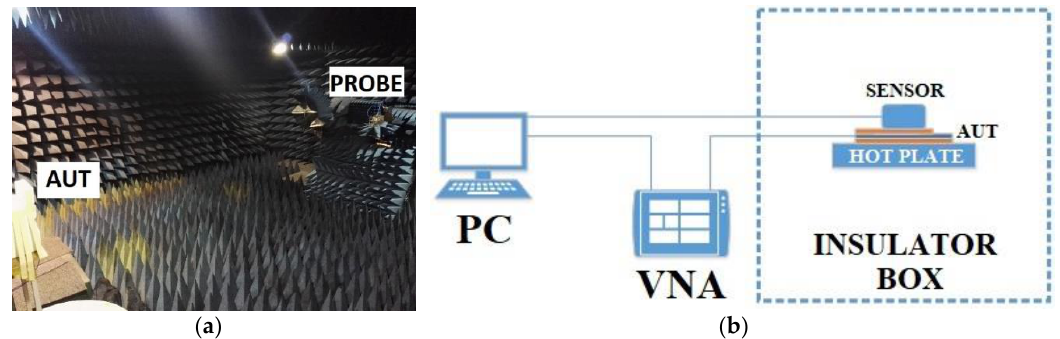
Figure 7. ( a ) Electromagnetic compatibility (EMC) anechoic chamber at Queen Mary University of London (QMUL) and ( b ) Measurement setup diagram.